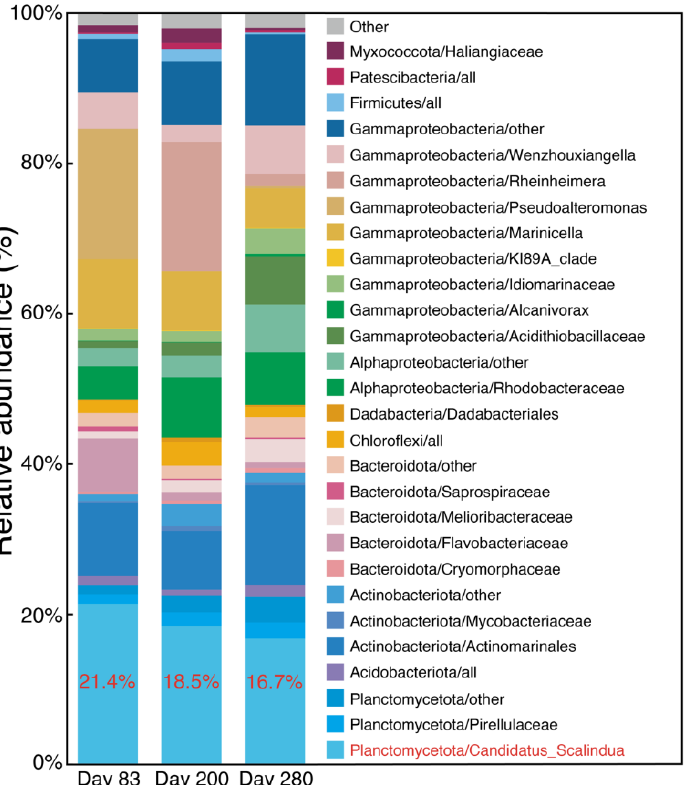
Figure 5. Microbial community composition at the end of each experimental phase (days 83, 200 and 280), based on 16S rRNA gene amplicon sequencing. Red percentages correspond to the relative abundance of the marine anammox Ca. Scalindua.